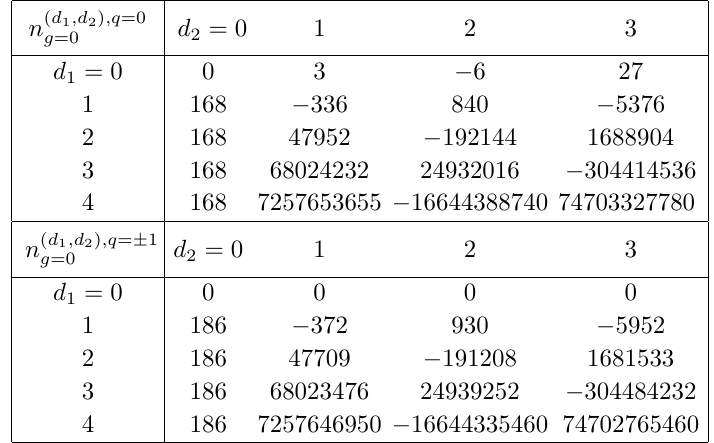
Table 7 . Z 3 -refined genus 0 GV-invariants with Z 3 charge q ∈ { 0 , ± 1 } associated to X (2)